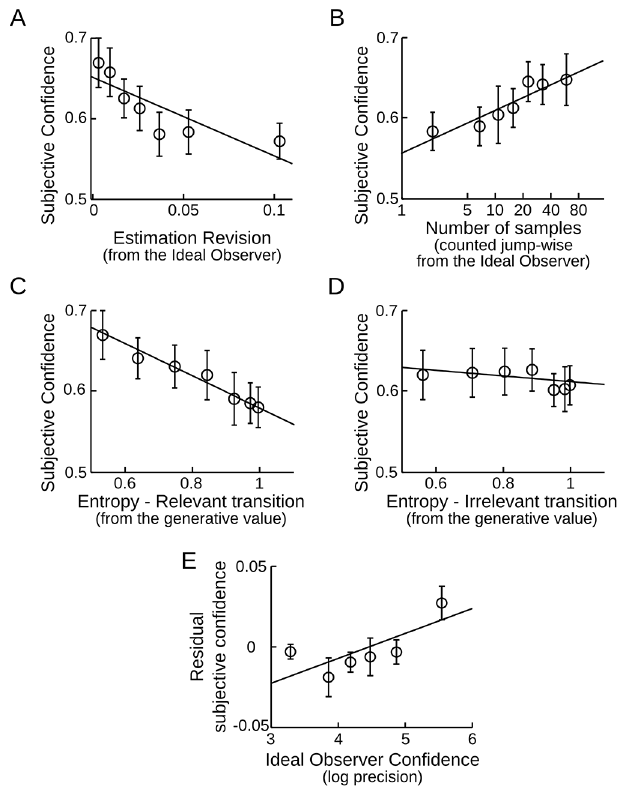
Fig 6. Subjective confidence is updated appropriately on a trial-by-trial basis. (A) Confidence varies inversely with model revision. The revision of probability estimates corresponds to the shift (absolute difference) in transition probabilities estimated by the Ideal Observer, between two consecutive observations of this transition. (B) Confidence increases when there is more information. Mathematically, confidence should increase linearly with the log-number of samples within stable periods; thus a log-scale is used to plot subjective confidence. The sample count was reset each time the Ideal Observer detects a new jump. (C , D) Confidence is reduced when transitions between stimuli are less predictable. The entropy reflects how unpredictable the next stimulus is based on the generative transition probability: p(A|A) or p(A|B). If the stimulus preceding the question is A, the relevant transition entropy is determined by p(A|A). By contrast p(A| B) is irrelevant. (E) Evidence that subjective confidence estimation goes beyond all of the above factors taken together. A multiple regression including the factors in panels A to D was used to compute the residual subjective confidence, which was then correlated with the Ideal Observer confidence. In all plots error-bars give the inter-subject mean ± s.e.m; the fitted line is the average of the linear fits performed at the subject level. Bins are used only for visualization and not for data